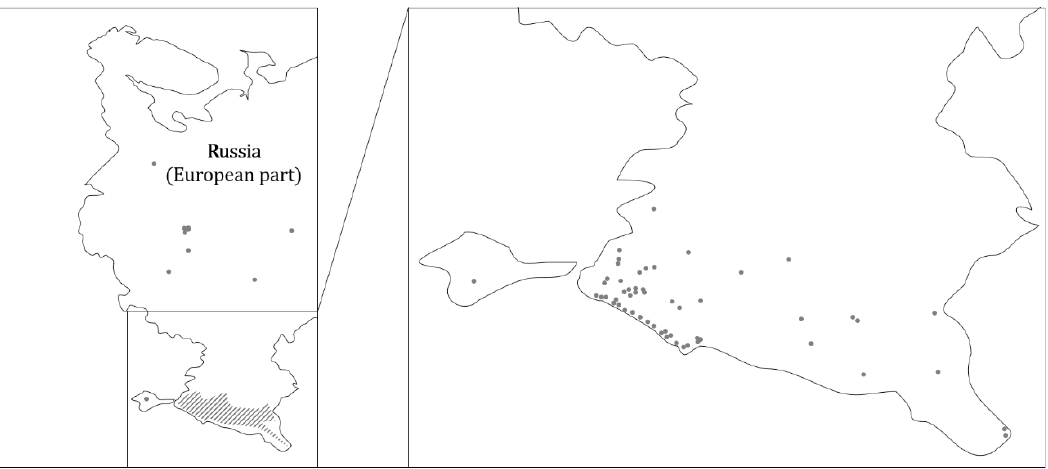
Figure 3. Occurrence of the raccoon in the European part of Russia (dark grey dots). Raccoons are repeatedly spotted in European Russia (left). However, the main populations are located in the Caucasus and on the Black Sea coast of the extreme southern part of European Russia (right). Distribution data were obtained from the Mammals of Russia portal (https://rusmam.ru/atlas/map; accessed on 18 November 2022)) in November 2022.